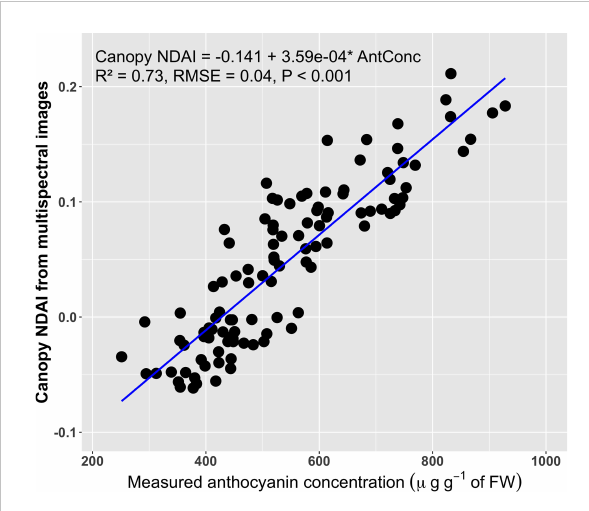
FIGURE 7 Correlation between the normalized difference anthocyanin index (NDAI) derived from RGB images and averaged over the entire visible part of the canopy and the canopy anthocyanin concentration (n = 108) (A) . The blue line is the regression line.